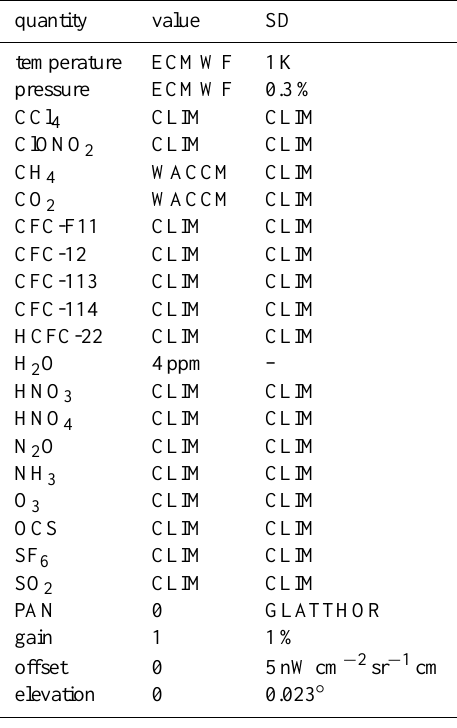
Table 4. Sources for a priori or background values and associated SDs for atmospheric quantities. CLIM refers to the climatology by Remedios et al. (2007), ECMWF and WACCM to the respective models, and GLATTHOR refers to the profile derived by Glatthor et al. (2007), where the derived values are taken as 1-sigma uncer-